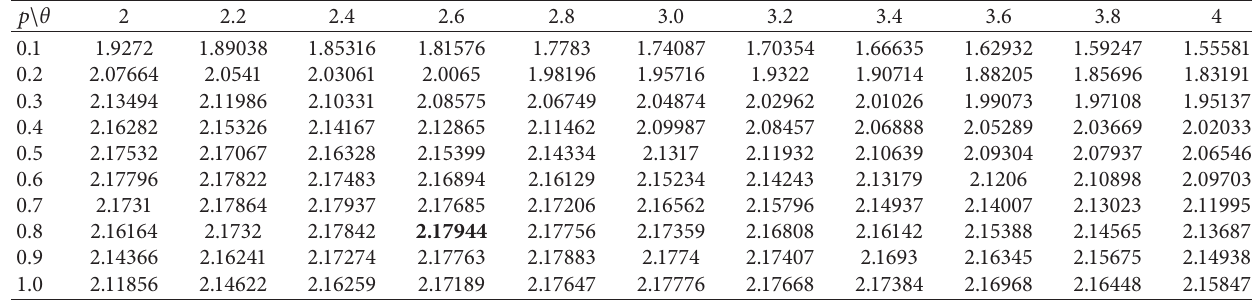
Table 1: The basic social welfare model: the expected social welfare for R � 5 ,C 0 . 4 , c � 0 . 5 , and δ � 0 .